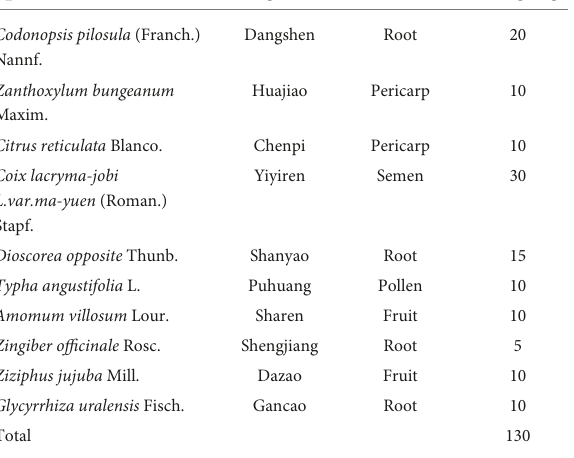
Table 1 . The plant taxonomy was confirmed using the MPNS database 1 and drug names were confirmed using the